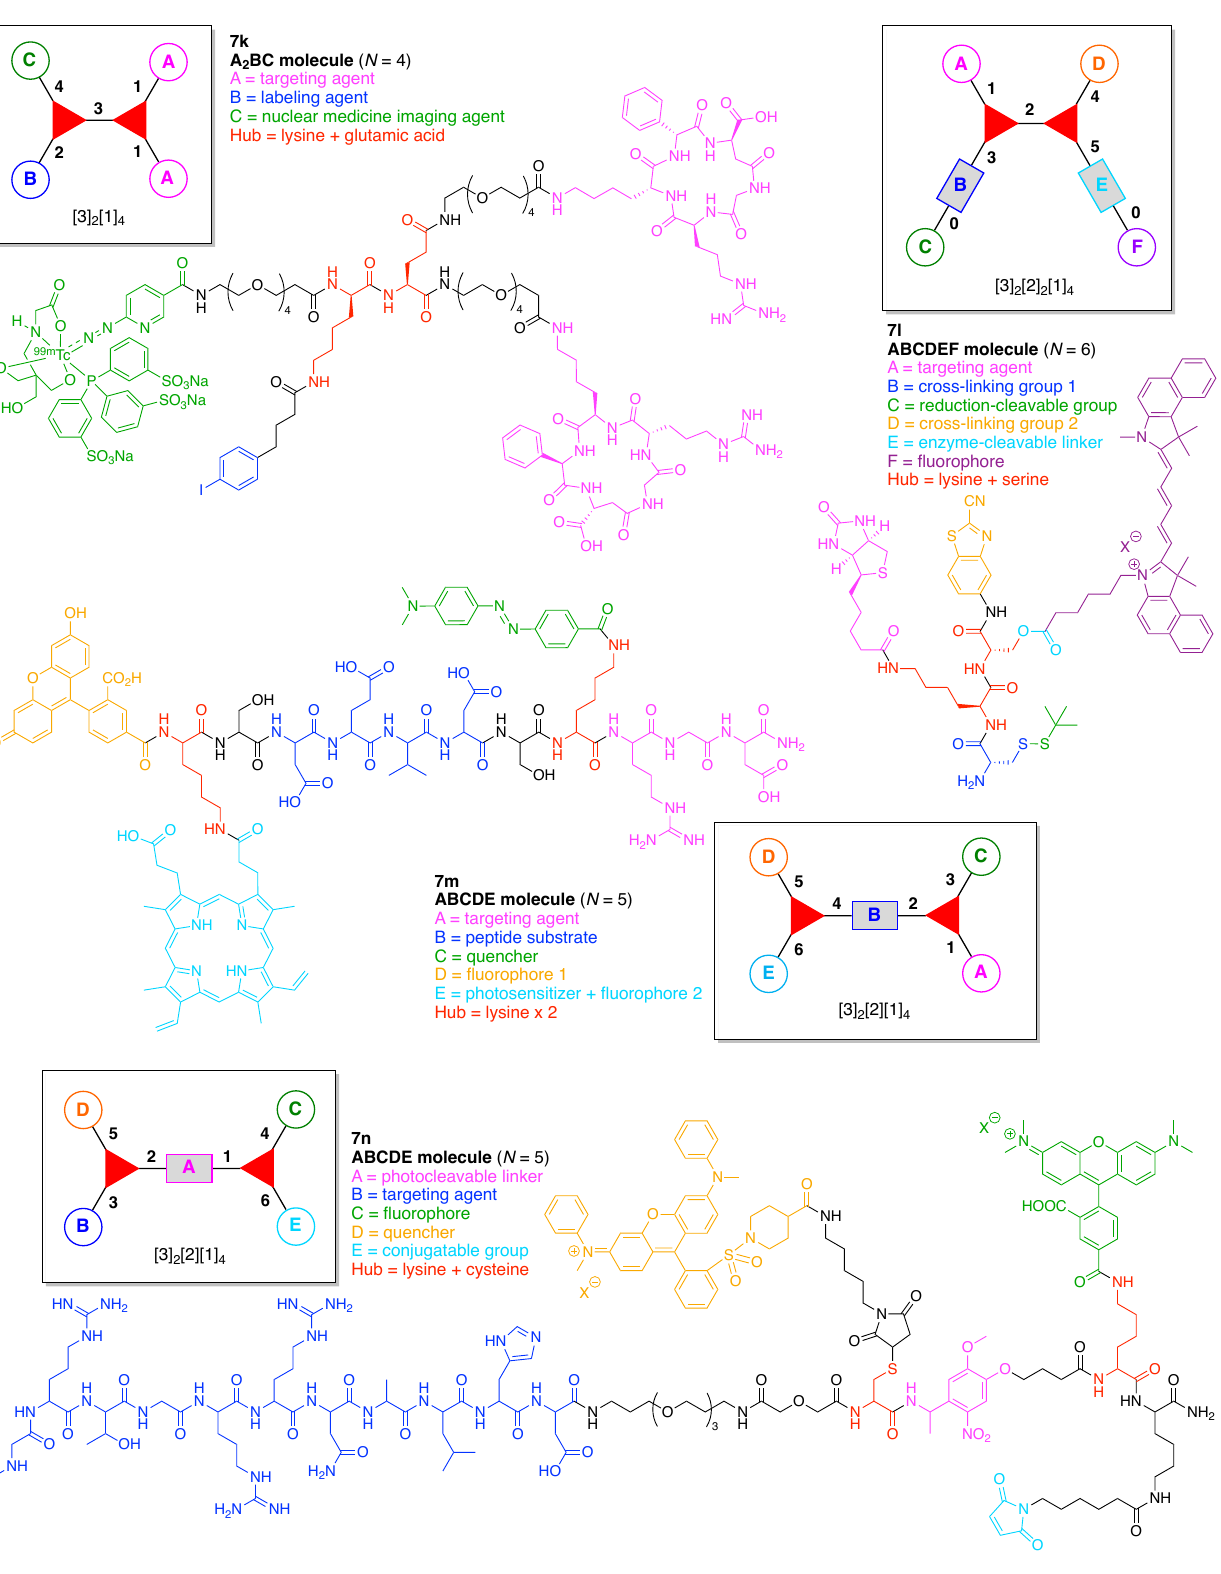
B = cross-linking group 1 C = reduction-cleavable group